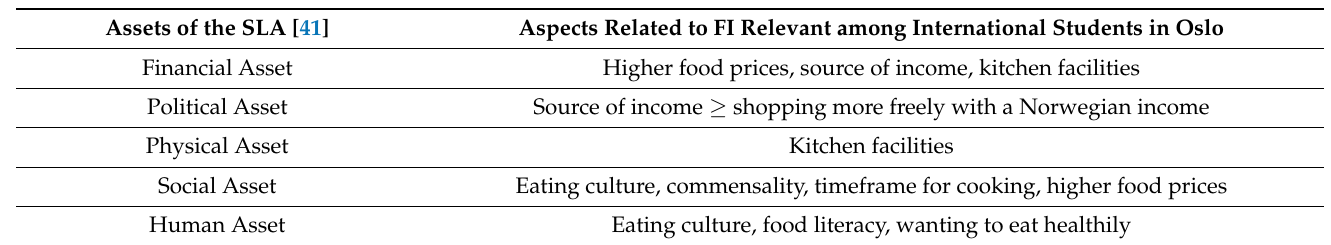
Table 2. Relation between assets of the SLA and aspects affecting FI among international